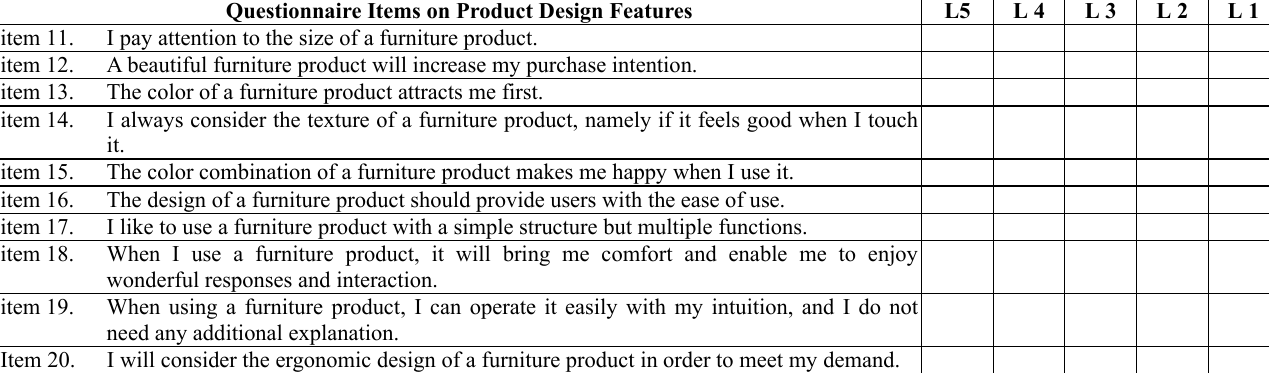
Table 1: Opinions and evaluation on product design features, including distinction, integration, and interaction The second part of the questionnaire: This part is for your opinions and evaluation on product design features, including distinction, integration, and interaction. Please answer the following questions according to your subjective feelings. “Strongly Agree” is Level 5, and the score ranges from 4.1 to 5, totally 10 equal portions. “More Agree” is Level 4, and the score ranges from 3.1 to 4, totally 10 equal portions. “Agree” is Level 3, and the score ranges from 2.1 to 3, totally 10 equal portions, “Disagree” is Level 2, and the score ranges from